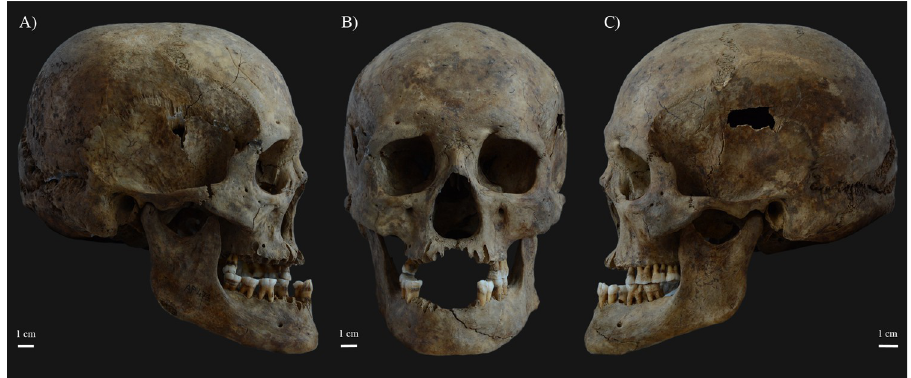
Surface pitting, subperiosteal new bone formations, and/or exostoses on the shaft of the lower leg bones, especially the distal half or